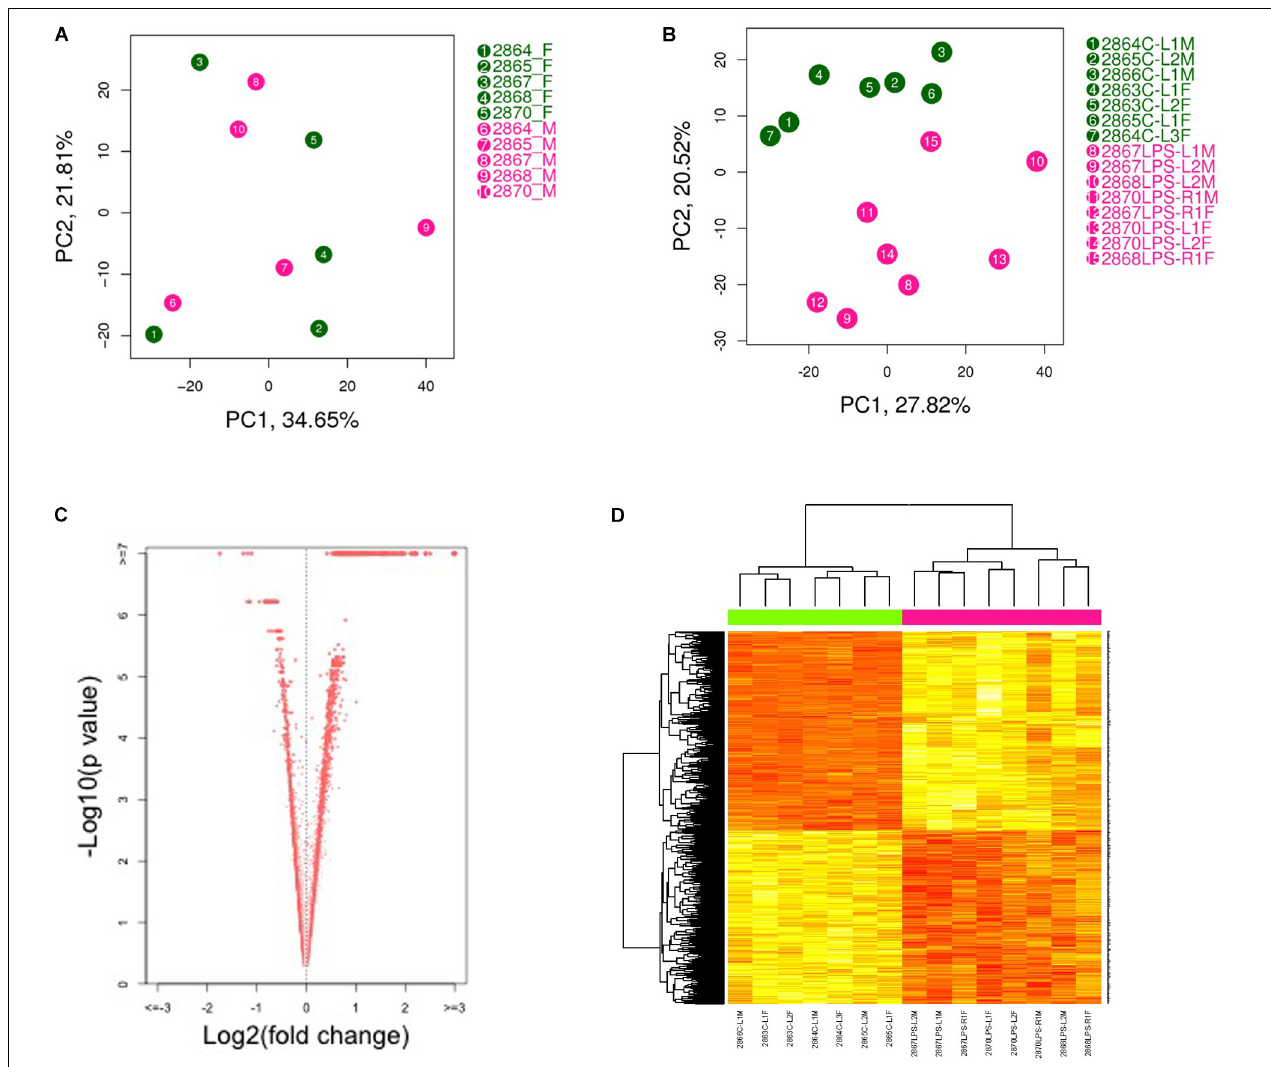
FIGURE 1 | Principal component analysis (PCA plot) of placental transcriptomes and differentially expressed genes. (A) PCA plots showed a strong impact of the litter but no significant differences between two genders. (B) PCA plot revealed significant separation between saline- and LPS-exposed groups. (C) Volcano plots identifying differentially expressed genes with an FDR ( q -value) < 0.05. (D) Heat map of differentially expressed genes showing significant differences between saline- and LPS-exposed groups. Each row in the heat map corresponds to data point from a single gene, whereas columns correspond to individual samples. The branching dendrogram corresponds to the relationships among samples, as determined by clustering using differentially expressed genes. Up- and down-regulation of gene expressions are shown on a continuum from yellow to red, respectively. N = 7 for saline group and N = 8 for LPS group.